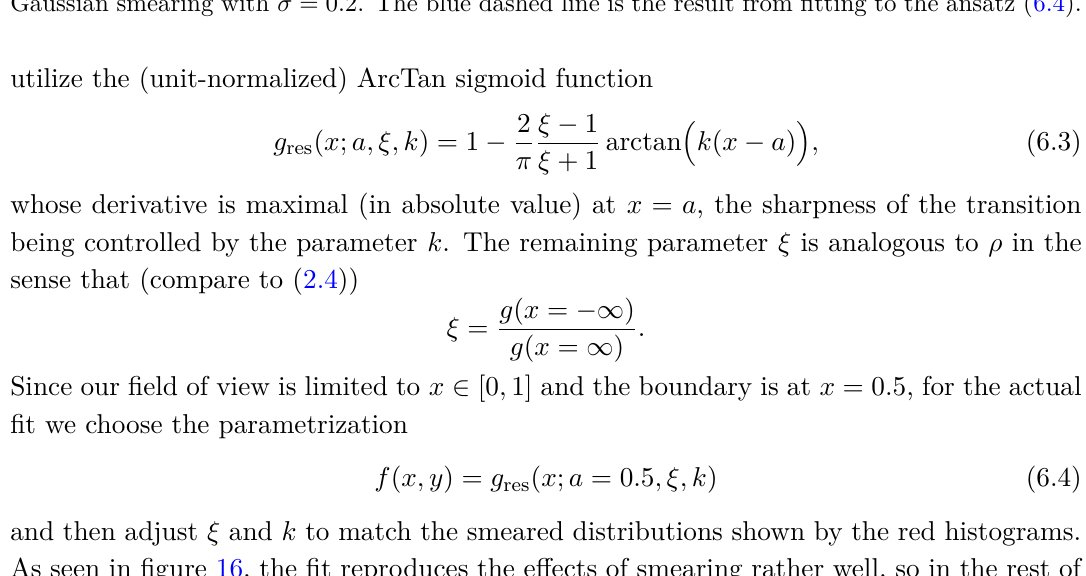
Figure 16 . The black dotted line shows the original distribution (2.5) for ρ = 5 (left panel) and ρ = 1 . 5 (right panel) before any smearing. The red solid histogram is the result from applying Gaussian smearing with σ = 0 . 2 . The blue dashed line is the result from fitting to the ansatz